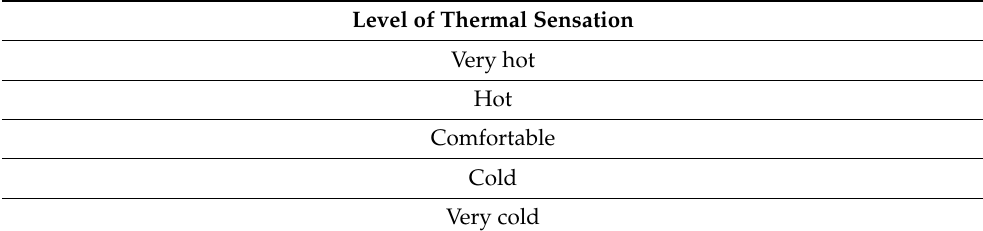
Table 4. Levels of thermal sensation according to ASV. Source